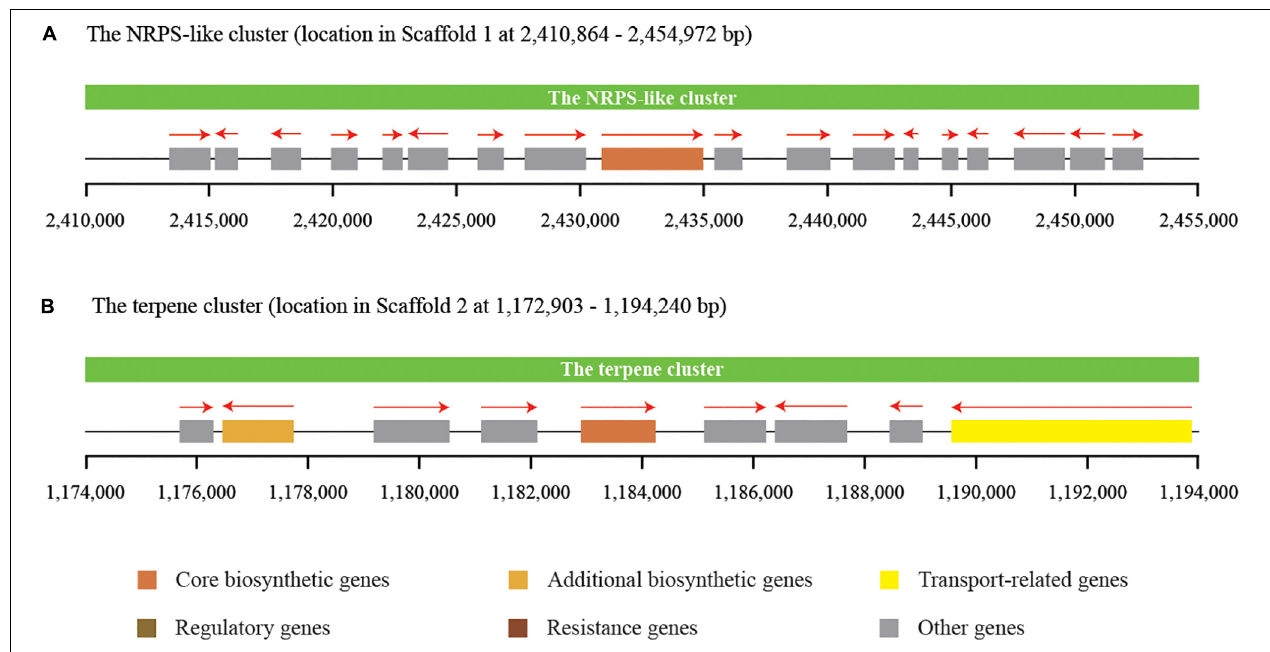
FIGURE 6 | Identification of two distinct secondary metabolite clusters in the genome of C. oleophila. ( A) The non-ribosomal peptide synthetase (NRPS)-like cluster is composed of 18 functional genes. (B) The terpene cluster is composed of nine functional genes. The rectangle denotes a functional gene, while the red arrow on the top indicates the transcriptional direction of each functional